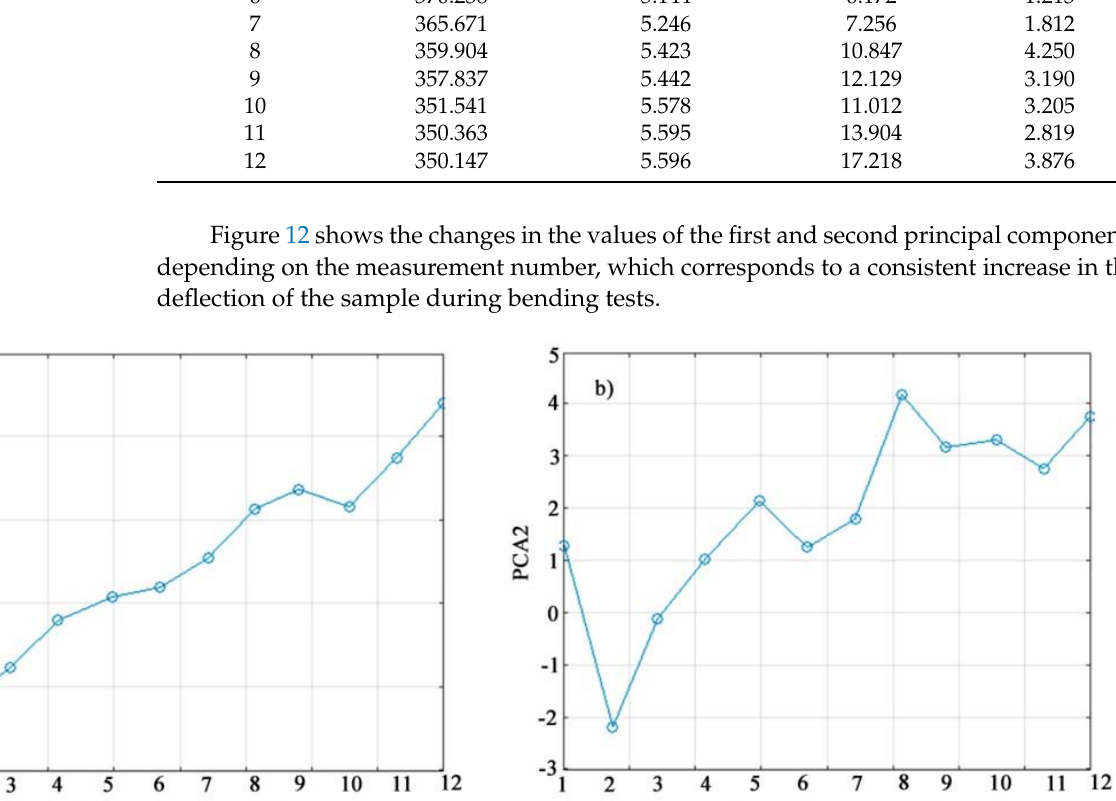
Figure 13. The first ( a ) and second ( b ) principal components as functions of the sample deflection (the dots show the values of the principal components for recorded AE signals, the solid line is the cubic spline approximation). The numerical characteristics of the first two principal components with a successive increase in deflection at the moments of successive fixation of AE signals revealed a linear trend of increase with increasing loading with a stable prospect of using the first principal component. As follows from the consideration of Figure 13, the first principal component quite stably describes the general trend of loading of a polymer coating on a metal base by the AE method, while the second allows a fairly clear separation of stages II and III, which was impossible to achieve when observing the change in the AE signal during loading and dependencies K = f ( Δ L ). The boundaries of stages III and IV are quite clearly traced when observing this sec- tion of the curve (Figure 13a) for the first principal component, where the character of this dependence changes. A comparison of Figures 8 and 13 reveals the identity of the hardening stages, and if in Figure 8 the division into stages was of a qualitative nature, then in Figure 13 their